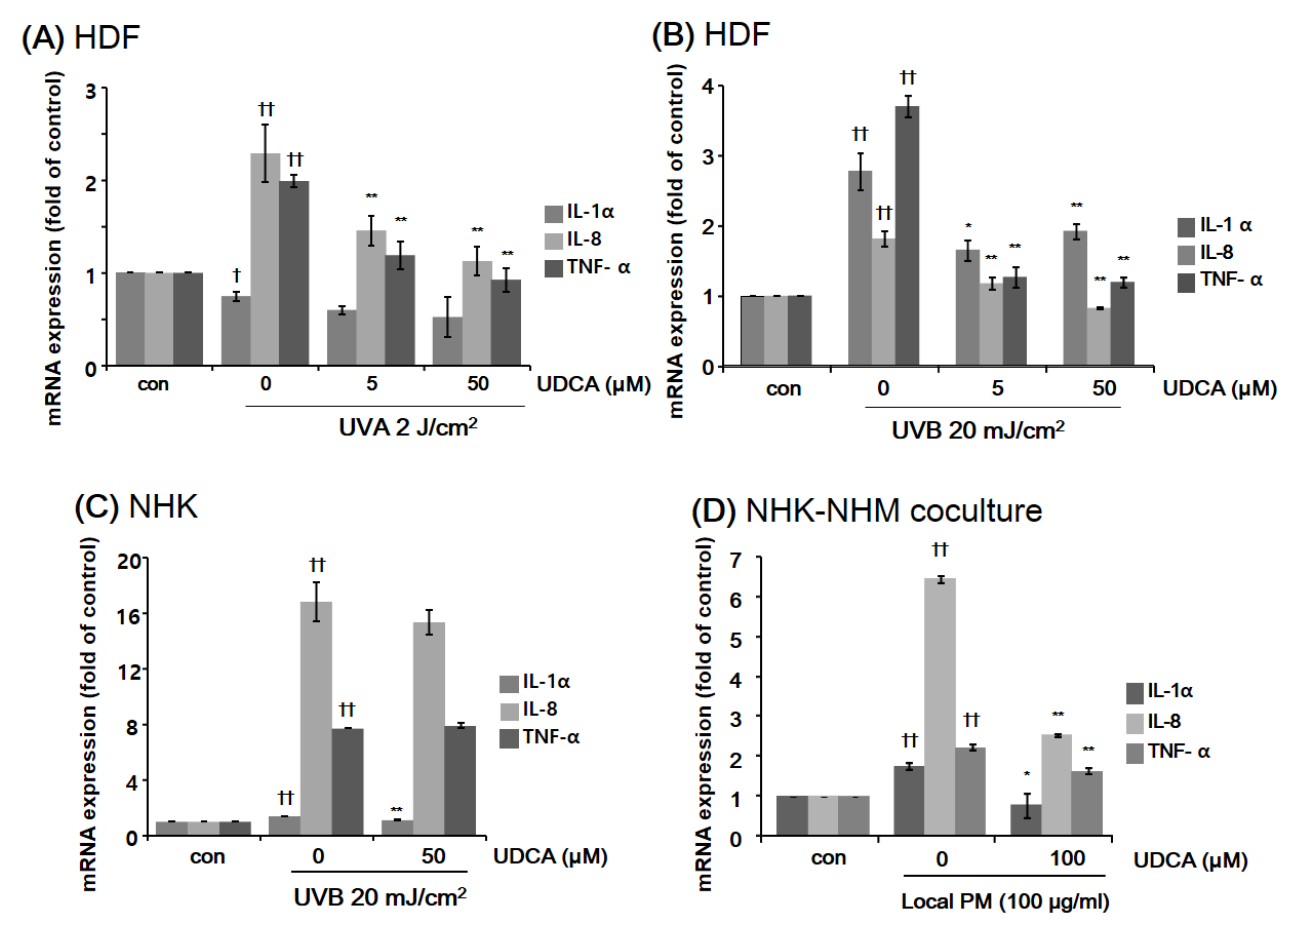
Figure 2. Anti-inflammatory effect of UDCA treatment. HDFs were exposed to ( A ) UVA and ( B ) UVB, which both induced incremental changes in mRNA expression of proinflammatory cytokines, including IL-1a, IL-8, and TNF- α . Downregulation of inflammatory cytokines was more prominent when HDFs were treated with 50 µ M UDCA as compared with 10 µ M UDCA. ( C ) Proinflammatory cytokine expression of normal human keratinocytes (NHKs) was also increased following exposure to UVB. However, IL-8 and TNF- α were not decreased by treatment with 50 µ M UDCA. ( D ) In a coculture consisting of NHKs and normal human melanocytes (NHMs), treatment with 100 µ M UDCA effectively downregulated the elevated mRNA expression levels of proinflammatory cytokines following exposure to local PM10. * p < 0.05 and ** p < 0.01 compared with UV-exposed or PM-treated control. † p < 0.05 and †† p < 0.01 compared with the null control (con).